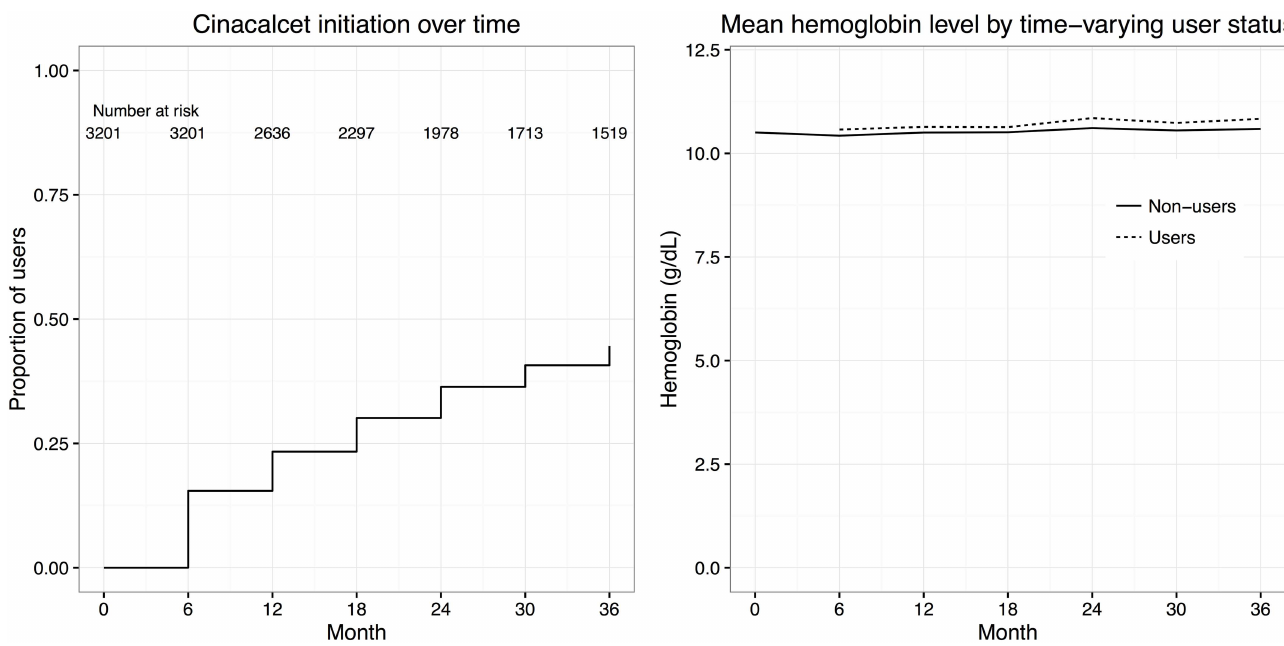
Fig 1. Cinacalcet initiation during the follow-up period, and mean hemoglobin level by time-varying cinacalcet status (user or non-user). 15.7% diabetic nephropathy vs 39.1% chronic glomerulonephritisand 30.1% diabetic nephrop-